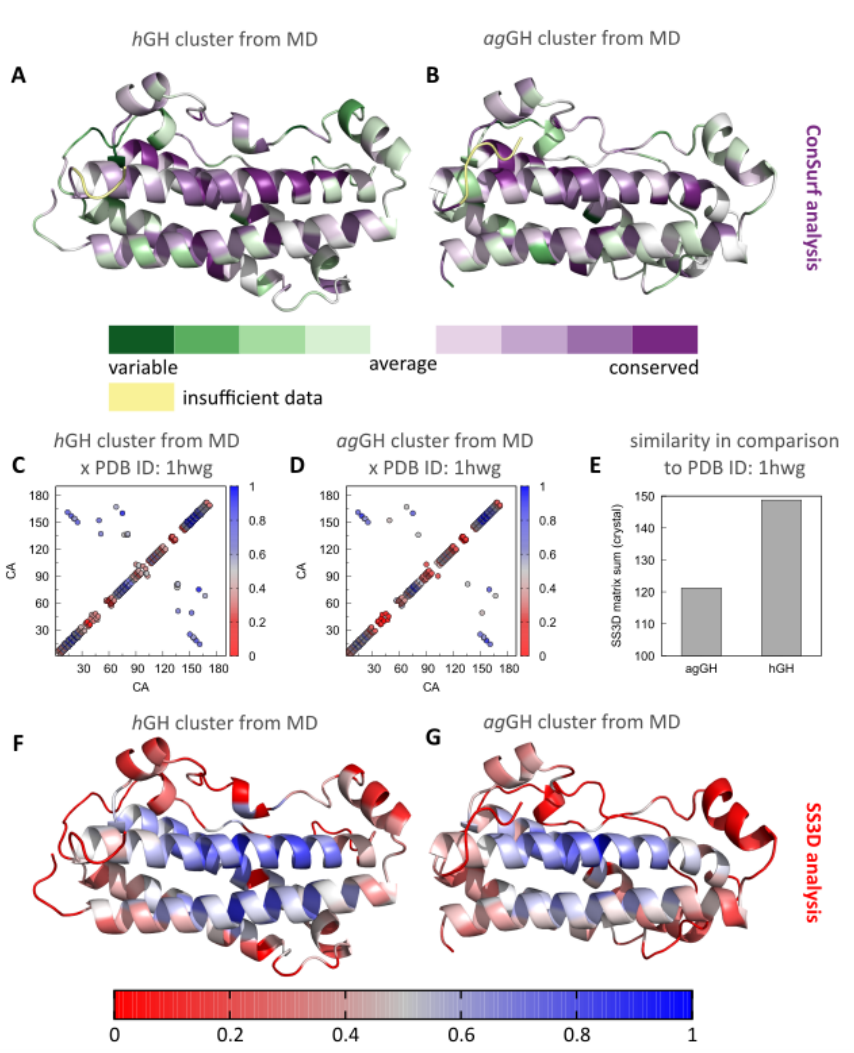
Figure 6. ConfSurf maps for the hGH model ( A ) and the ag-GH model ( B ) display the highly conserved regions of the proteins (purple) and the highly variable amino acid sites (green). Contact maps from the SS3D analysis for the hGH model ( C ) and the ag-GH model ( D ), as well as the overall SS3D similarity in comparison with the experimental template structure (PDB ID: 1hwg) ( E ), and the maps from the SS3D similarity analysis ( F , G ).